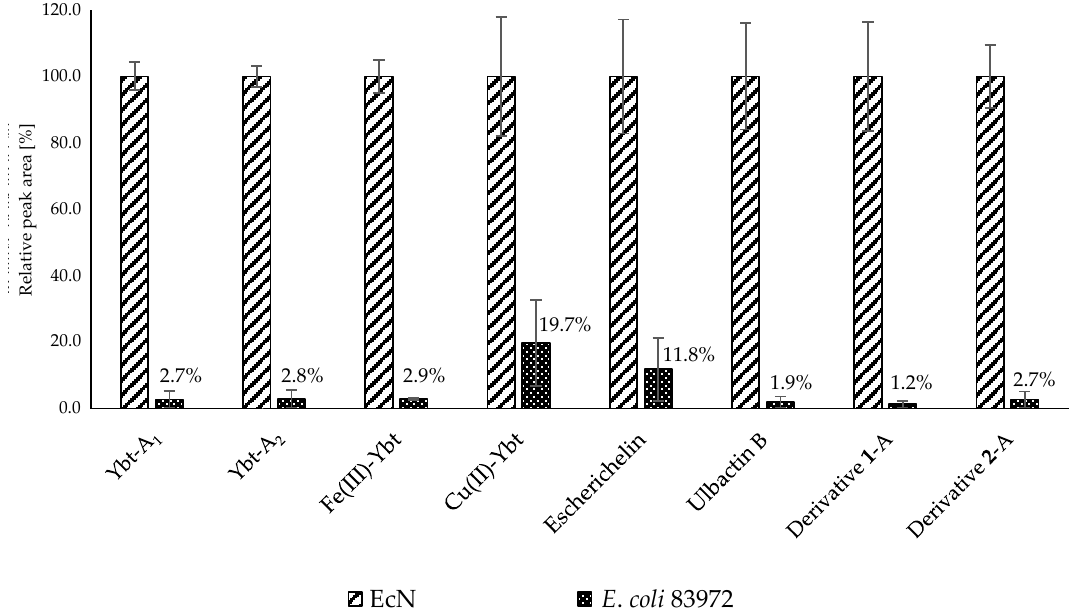
Figure 5. Relative peak areas of Ybt and the derivatives of the culture supernatant from E. coli strains EcN and 83972 after LC-MS / MS